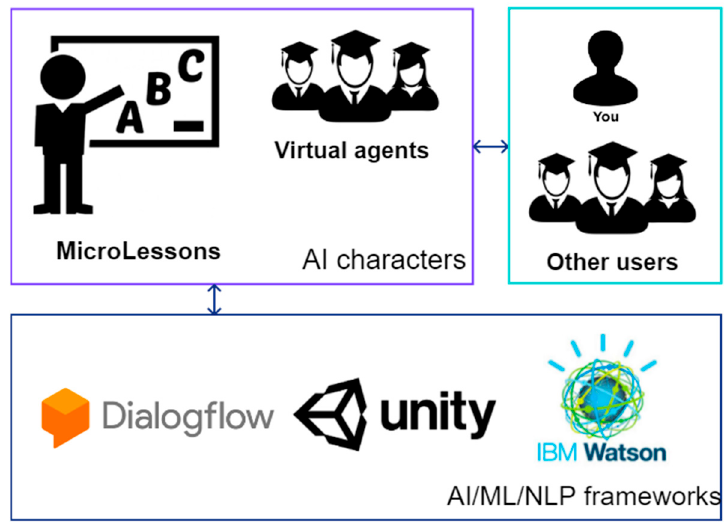
Figure 4. Intelligent agents software design.